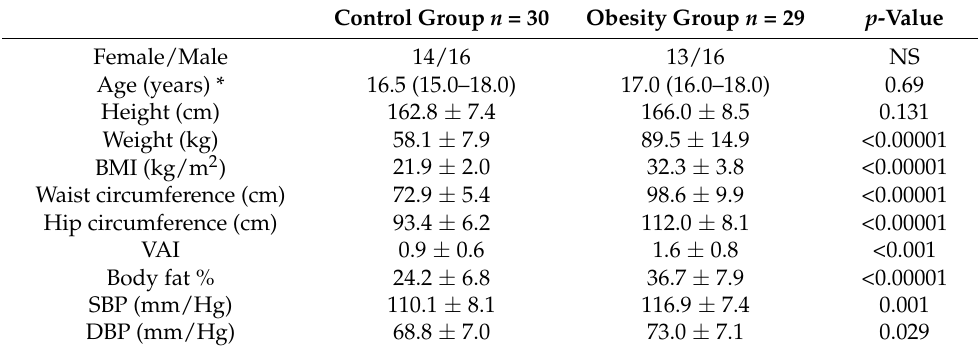
Table 1. Clinical characteristics of